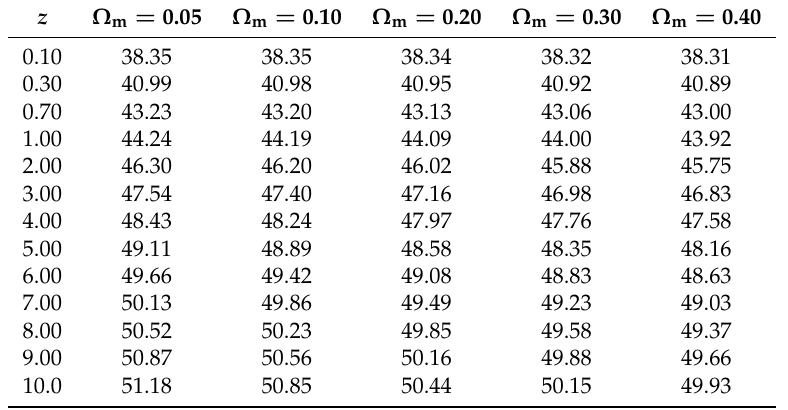
Table 1. Values of ( m − M ) as a function of redshift z for different density parameters Ω m . z Ω m = 0.05 Ω m = 0.10 Ω m = 0.20 Ω m = 0.30 Ω m =